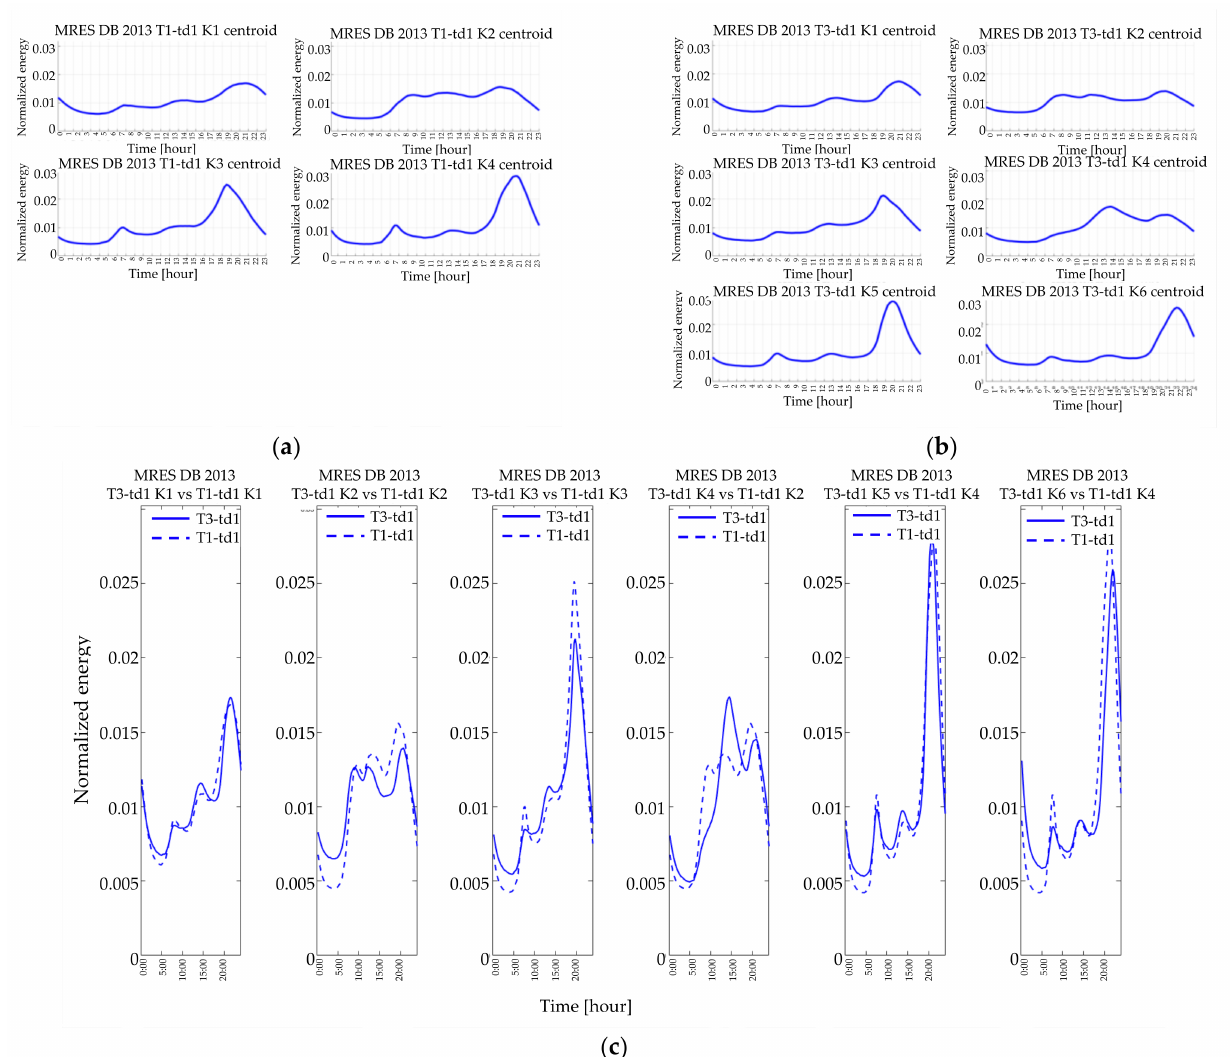
Figure 14. Database 2013, main residence contract (MRES) costumer, normalized centroids: ( a ) winter workdays (three clusters), ( b ) summer workdays (three clusters), ( c ) comparison between the two typical